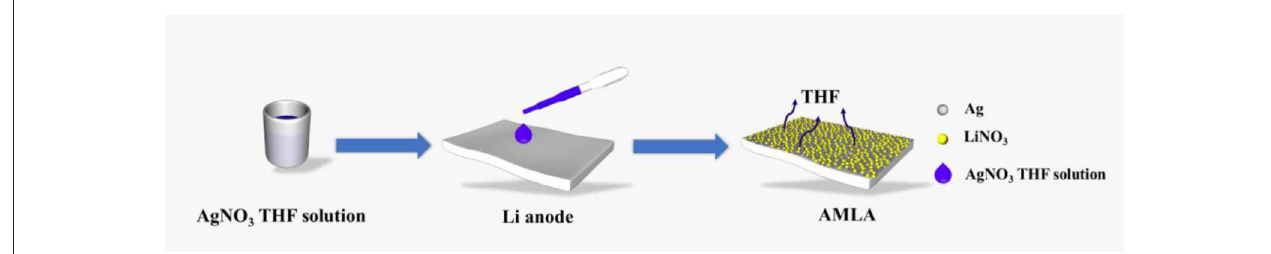
FIGURE 1 | The illustration of the synthesis of the AMLA.